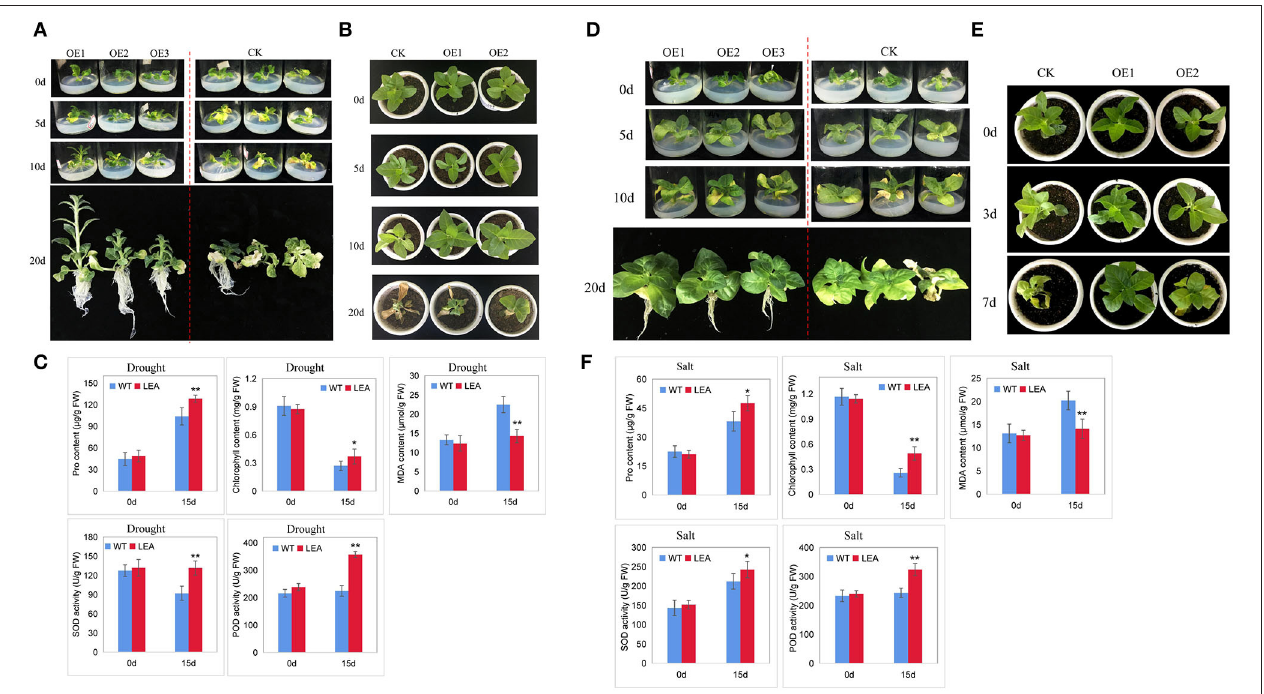
FIGURE 6 | Overexpression of PeLEA14 in tobacco. (A–C) indicate evaluation of tolerance of wild type (WT) and transgenic lines (OE) to drought stress at seedling (1/2MS solid medium containing 200mM mannitol) and adult (natural drought by withholding watering) stages and stress-related physiological parameters, respectively. (D–F) indicate evaluation of tolerance of WT and transgenic lines (OE) to salt stress at seedling (1/2MS solid medium containing 100mM NaCl) and adult (applying 300mM NaCl solution into the tray) stages and stress-related physiological parameters,